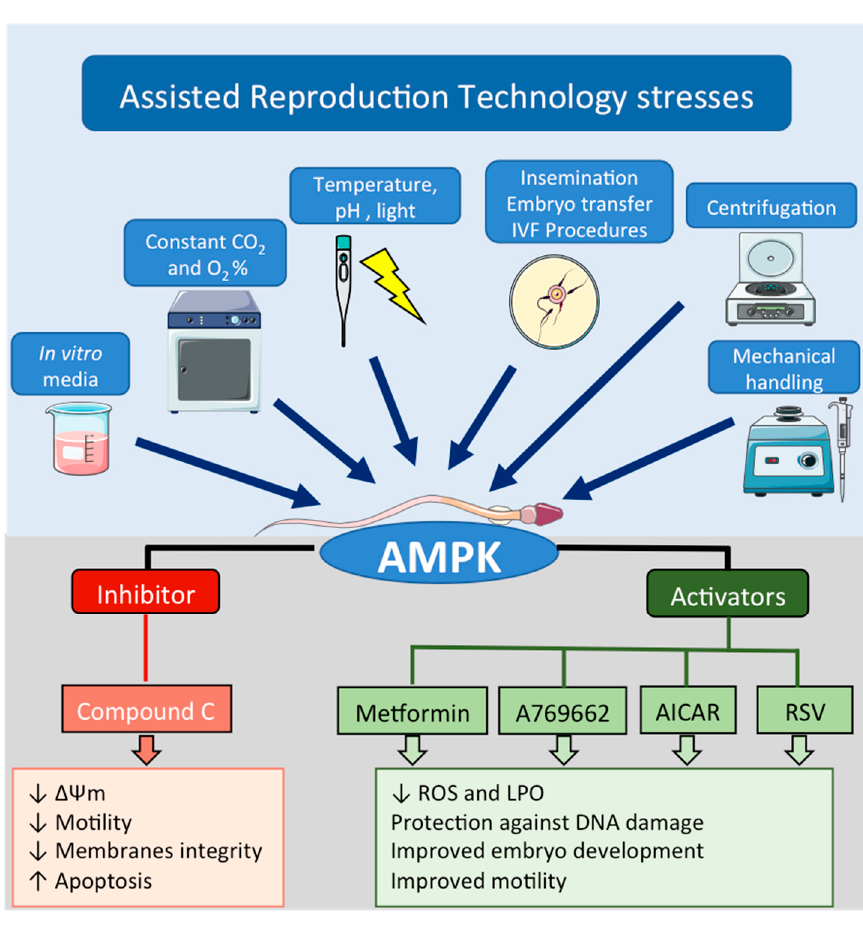
Figure 5. Effects of the modulation of AMPK activity (up or down) in spermatozoa during Assisted Reproduction Techniques (ART), including In Vitro Fertilization (IVF). During ART, spermatozoa are